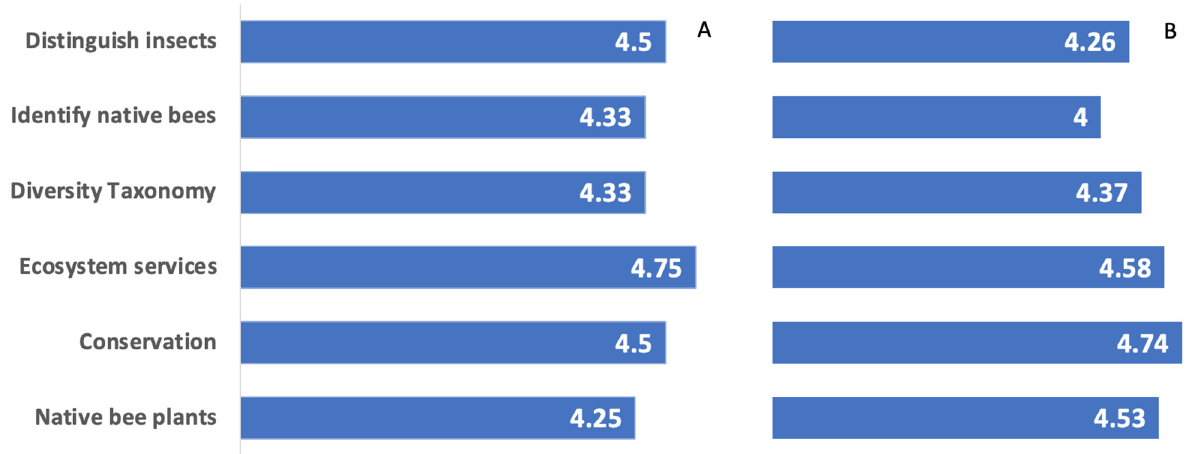
Figure 3. General Perceived Knowledge Gains (2019) Proportion of participants’ retrospective ratings of their general knowledge levels of native bees on a 5-point scale (from light to dark, 1—poor, 2—fair, 3—good, 4—very good, 5—excellent) based on the statement, “I would rate my knowledge of native bees as...”. This translated to a significant increase between the pre-course mean of 1.65 (+/ − 0.21) and the post-course mean of 3.35 (+/ − 0.18) ( p < 0.000) (see Supplementary Table S5). Participants are represented by rectangles on the x -axis.